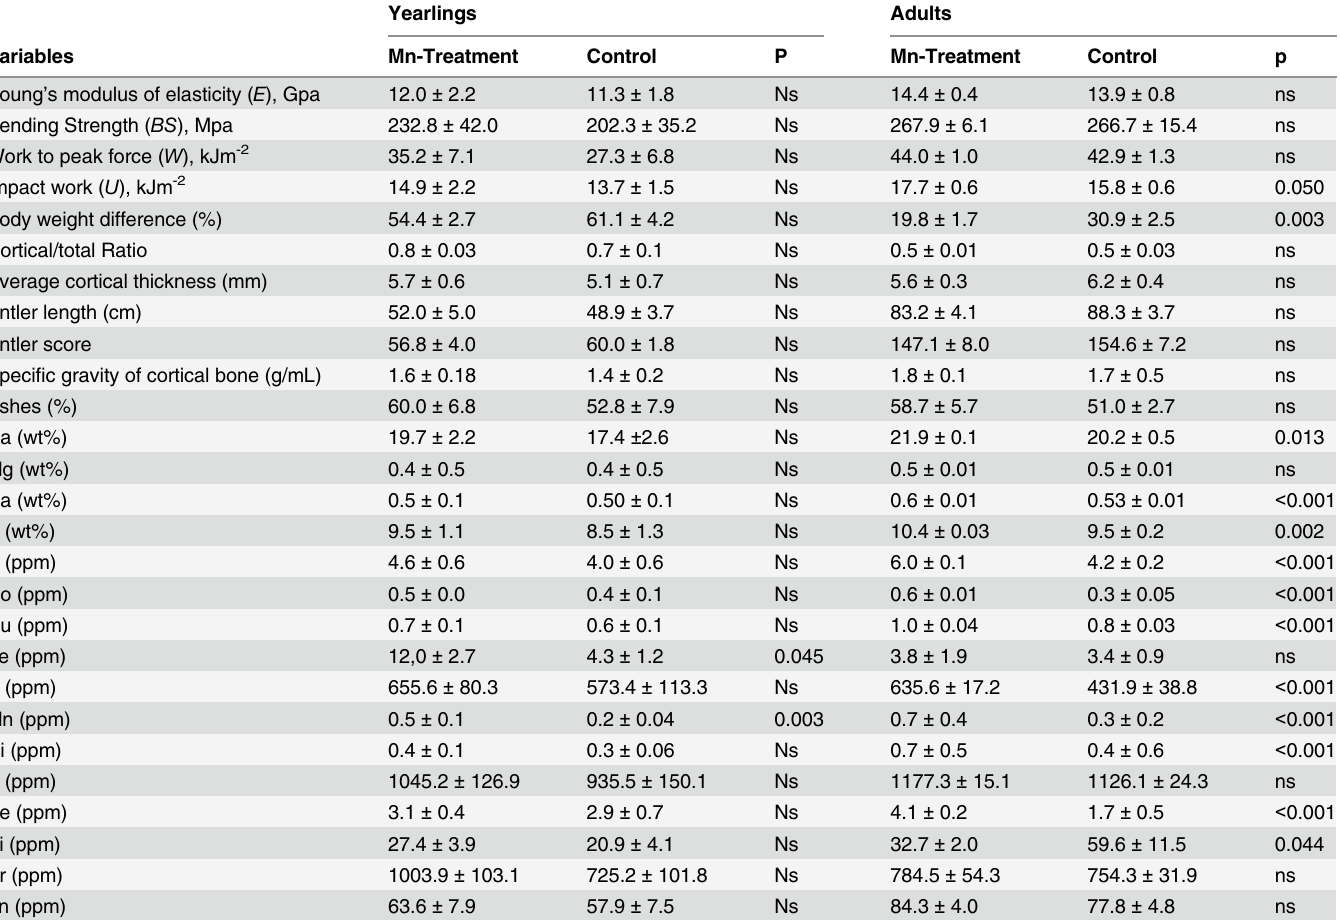
Table 1. Antler characteristics of spiker and adult red deer injected (Mn treated) or not (Control) with manganese as nutrient supplement. P corre- sponds to one-way ANOVA on the mean ( ± SE) per antler of the four positions